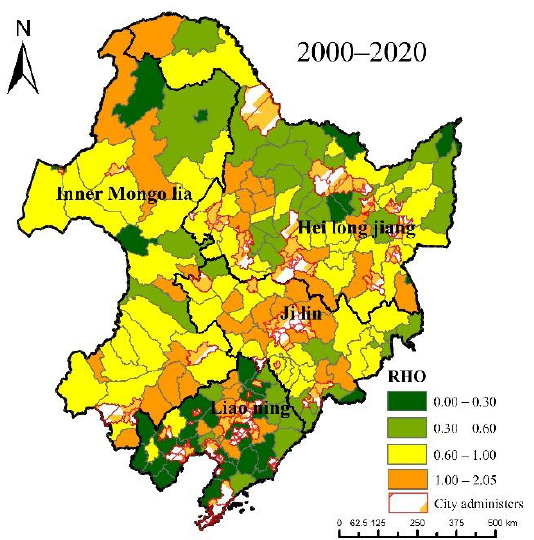
Figure 7. Spatial and temporal distribution of population clustering capacity in rural settlements in Northeast China.